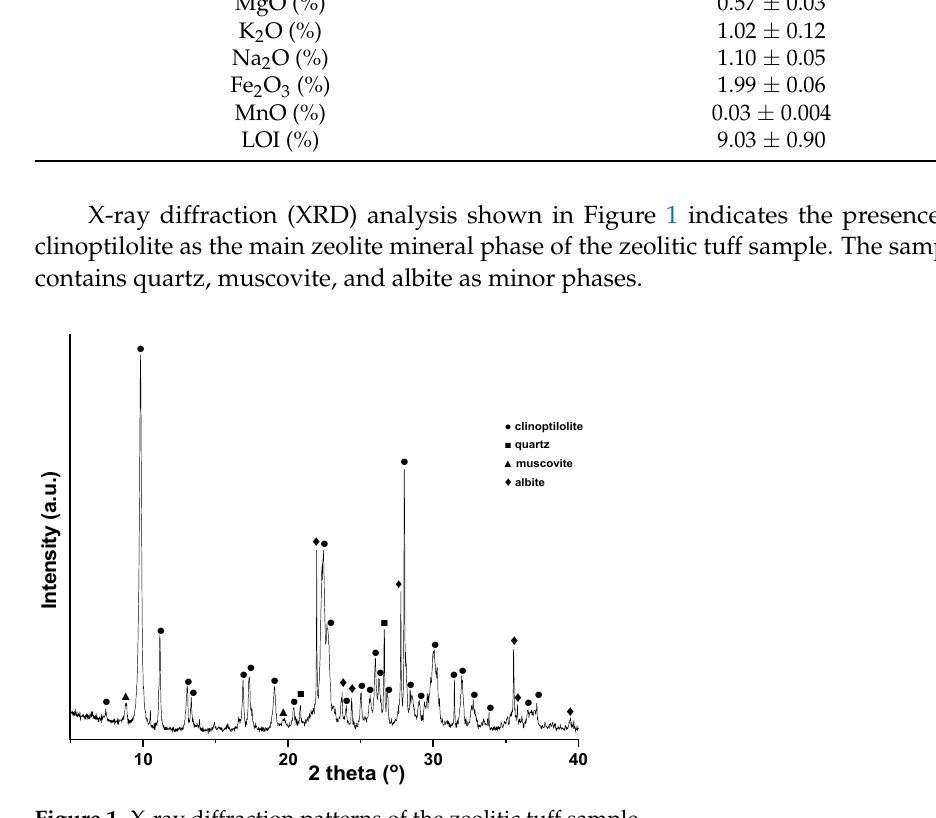
Figure 1. X-ray diffraction patterns of the zeolitic tuff sample.